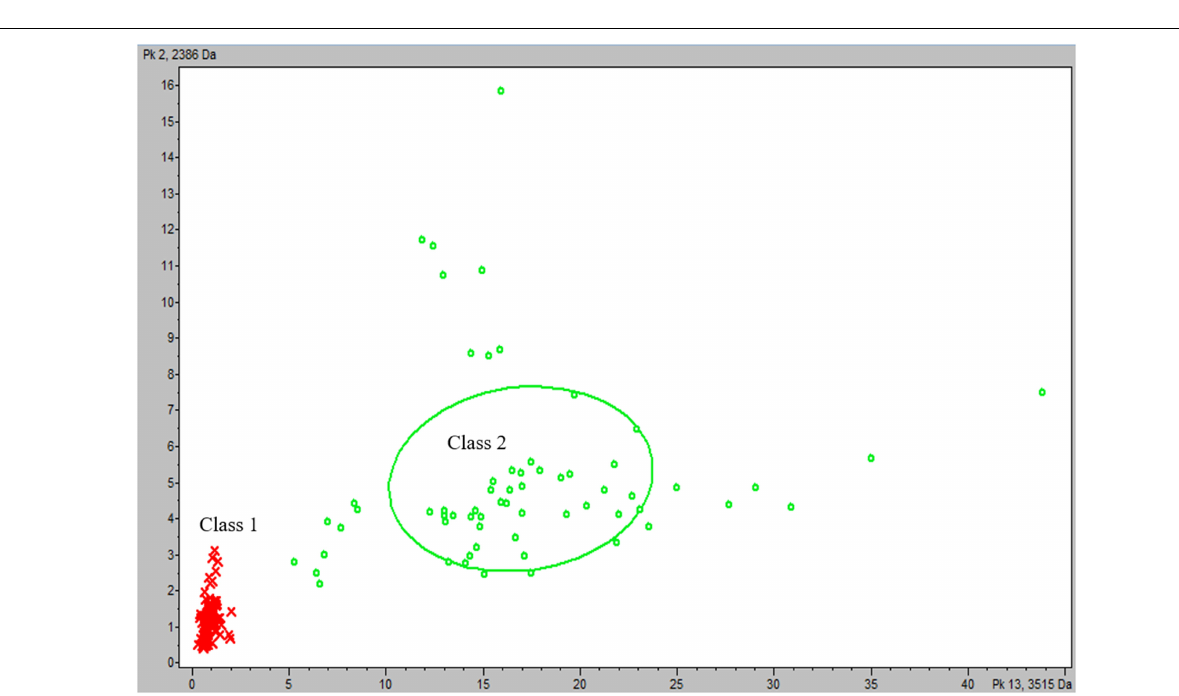
Frontiers in Microbiology |